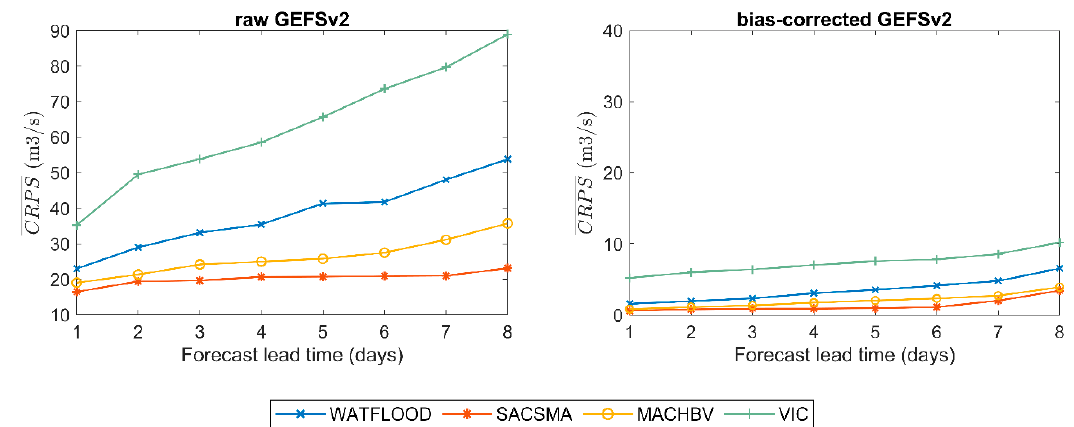
Figure 6. Mean CRPS of ensemble reservoir inflows generated with Raw ( left ) and Bias-corrected ( right ) ensemble GEFSv2 precipitation forecasts.